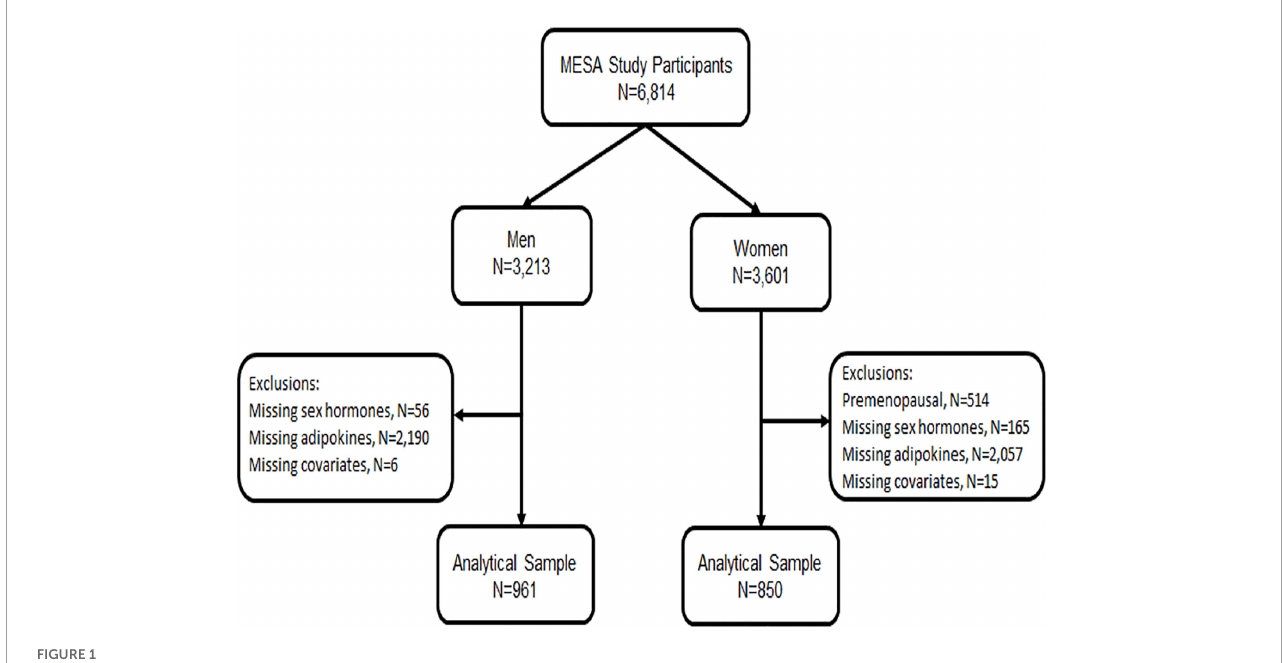
FIGURE1 Study flow